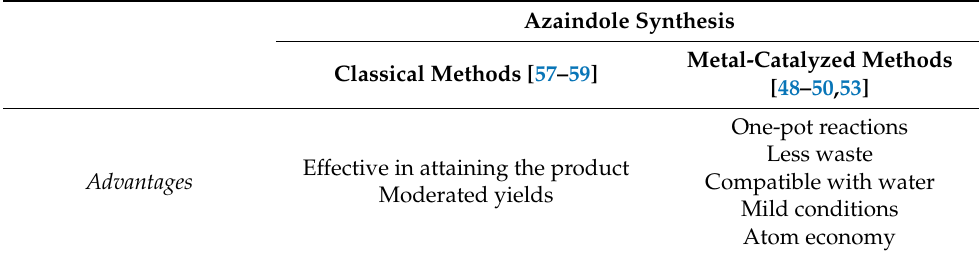
Table 1. Comparison of the classical methods versus metal-catalyzed reactions for the synthesis of